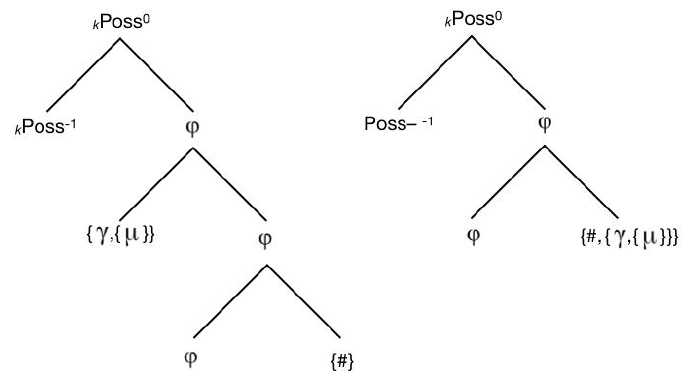
Figure 11. Complete sub-atomic composition of the Asturian